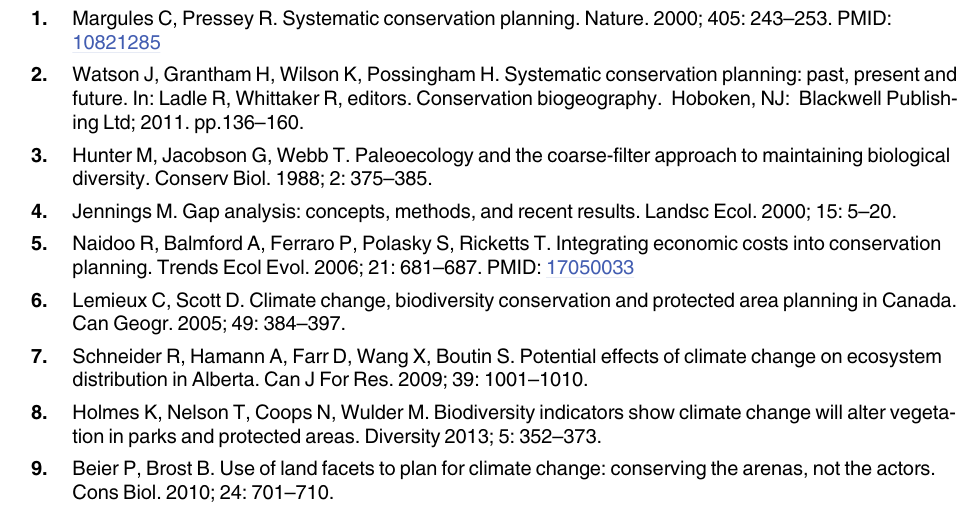
S2 Fig. Representative Marxan reserve design. Parameters included a 15% representation tar- get and no boundary penalty. (TIF) S3 Fig. Representative Marxan reserve design. Parameters included a 15% representation tar- get and high boundary penalty. (TIF) S4 Fig. Representative Marxan reserve design. Parameters included a 30% representation tar- get and no boundary penalty. (TIF) S5 Fig. Representative Marxan reserve design. Parameters included a 30% representation tar- get and high boundary penalty. (TIF) S6 Fig. Climate envelope projections for the HADGEM — A2 GCM (extreme model). Panel A = 2050s; panel B = the 2080s. Three Subregions in northeast Alberta were not modeled. (TIF) S1 Note. Model construction and fit for the bioclimatic envelope models.